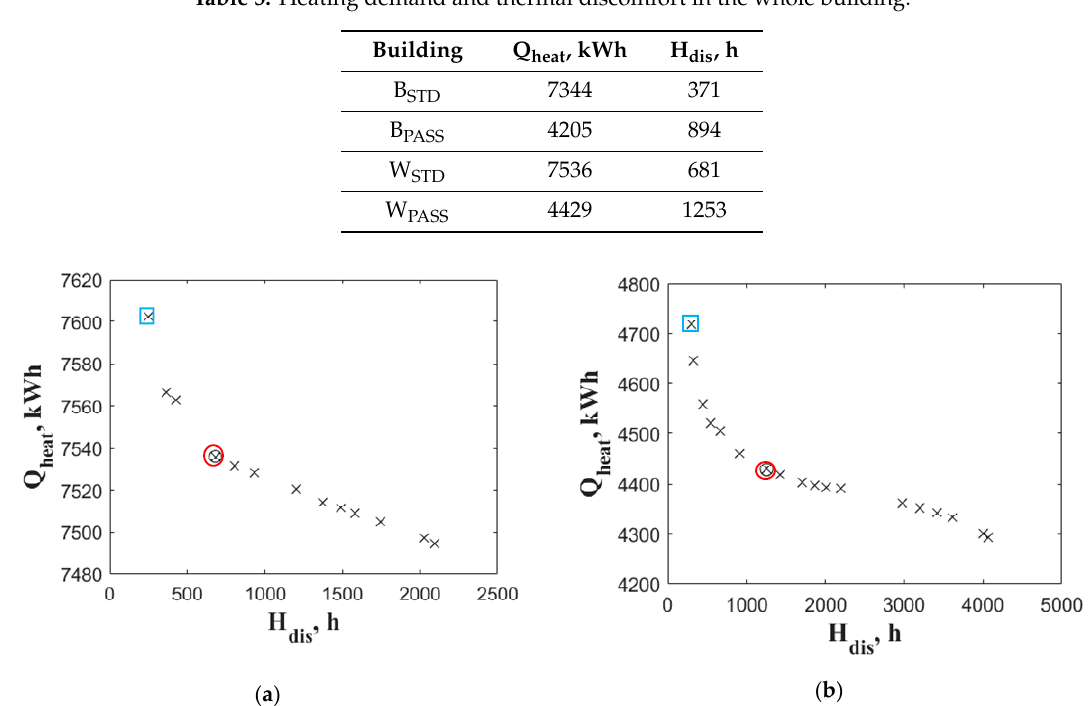
Figure 7. Pareto Front for the wooden buildings W STD ( a ) and W PASS ( b ).